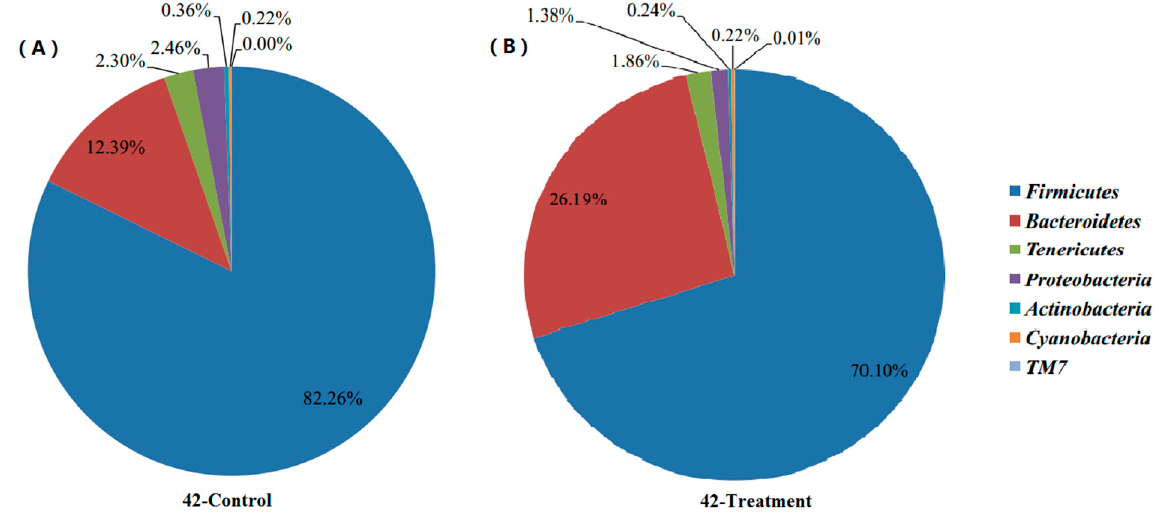
Figure 2. Effects of lecithin on the profiles of cecal microbial community after 42 days according to phylum for the control group ( A ) and lecithin treatment group ( B ).